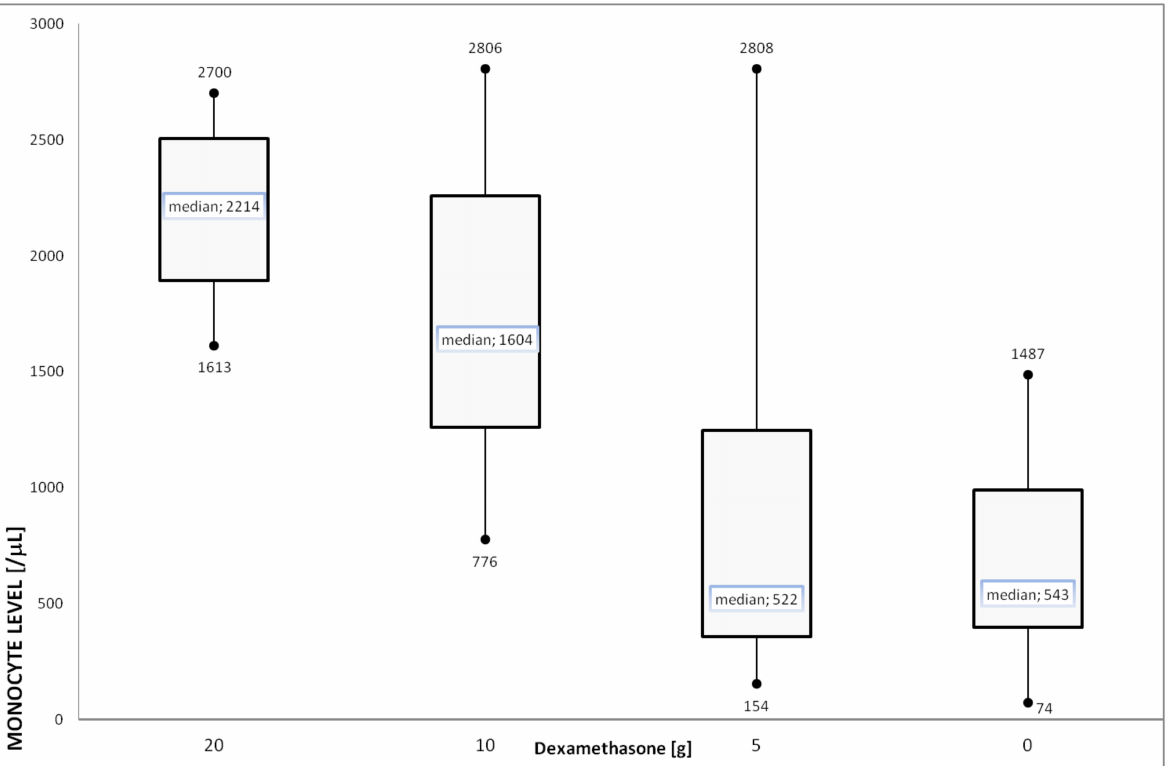
Figure 5. Various monocyte levels (hematology autoanalyzer) under the influence of ongoing gluco- corticoid therapy. The dose of steroids was presented as an equivalent dose of dexamethasone that forms a geometric sequence (ar n ) with common ratio r = 2 and start term a = 5 (exponential growth). For comparison, the subgroups within included patients (see Material and Methods), monocytosis was presented in included patients (also anti-CMV+ and immunodeficient) that had never been treated with steroids (right bar). The interquartile range (IQR) was about 1.5-fold higher for 5 and 10 mg of dexamethasone than 0 and 20